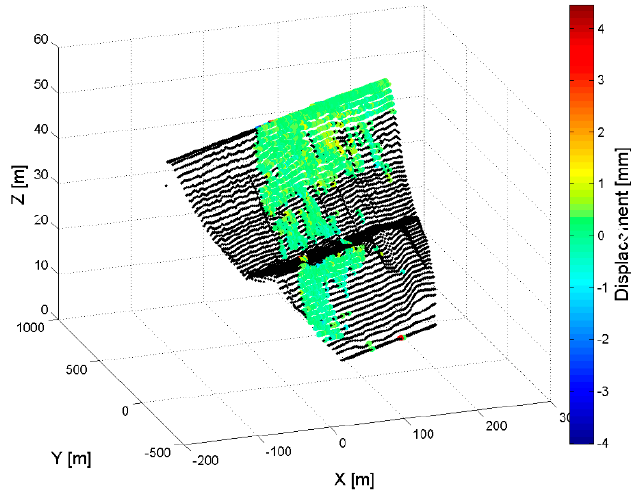
Figure 9. Marana-Capacciotti dam, Cerignola. Amplitude of the horizontal displacement map represented over the dam surface.